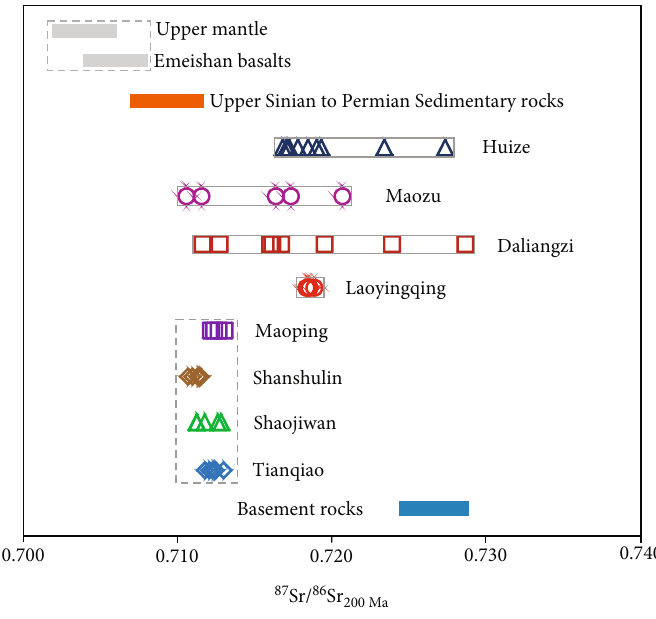
Figure 10: Comparison of ( 87 Sr/ 86 Sr) ( t = 200 Ma) ratios among the major SYGT Pb – Zn deposits, sedimentary rocks, basement rocks, t Emeishan basalts, and upper mantle. Sr isotope compositions of the Huize deposit are taken from Yin et al. [53]; those of the Maozu deposit are taken from Zhen et al. (2015); those of the Maoping deposit are taken from Shen et al. [116]; those of the Daliangzi deposit are taken from Zhang et al. [15]; those of the Shanshulin deposit are taken from Zhou et al. [54] and Cheng et al. [115]; those of the Shaojiwan deposit are taken from Zhou et al. [55]; those of the Tianqiao deposit are taken from Zhou et al. [8] and Cheng et al. [115]. The Sr isotopic compositions of the reservoirs are all calculated back to 200Ma with original data from Faure [117] for the upper mantle; from Huang et al. [102] for the Emeishan basalts; from Deng et al. [32], Hu [33], Zhou et al. [55], and Zhou et al. [54] for the sedimentary rocks; and from Li and Qin [118] and Chen Ran [119] and for the Proterozoic basement